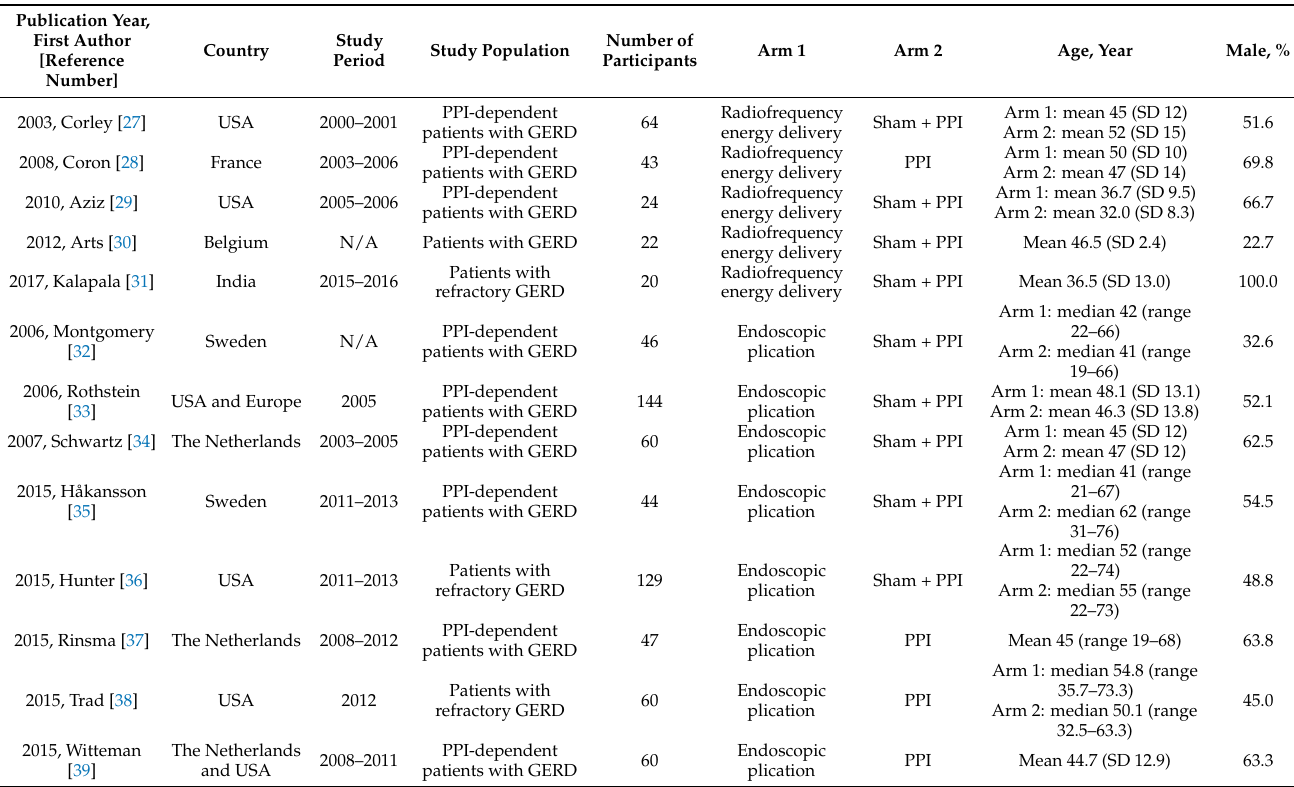
Table 1. Baseline characteristics of the included